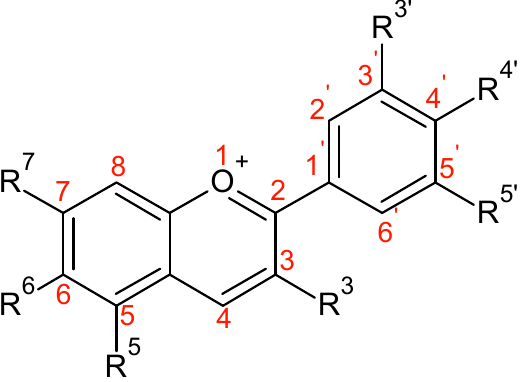
Figure 2. Anthocyanin structure.